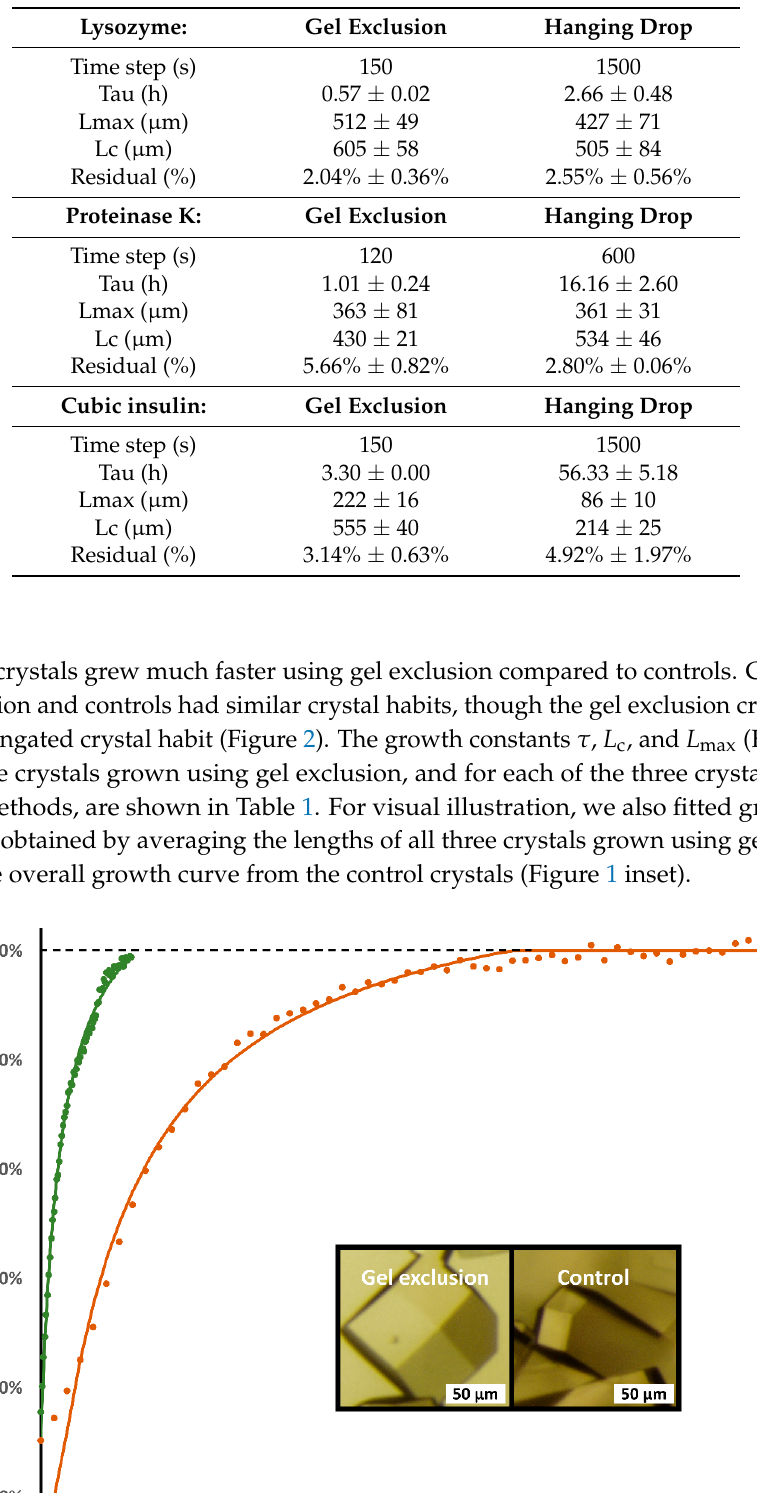
Table 1. Refined curve fitting parameters for crystal growth curves.